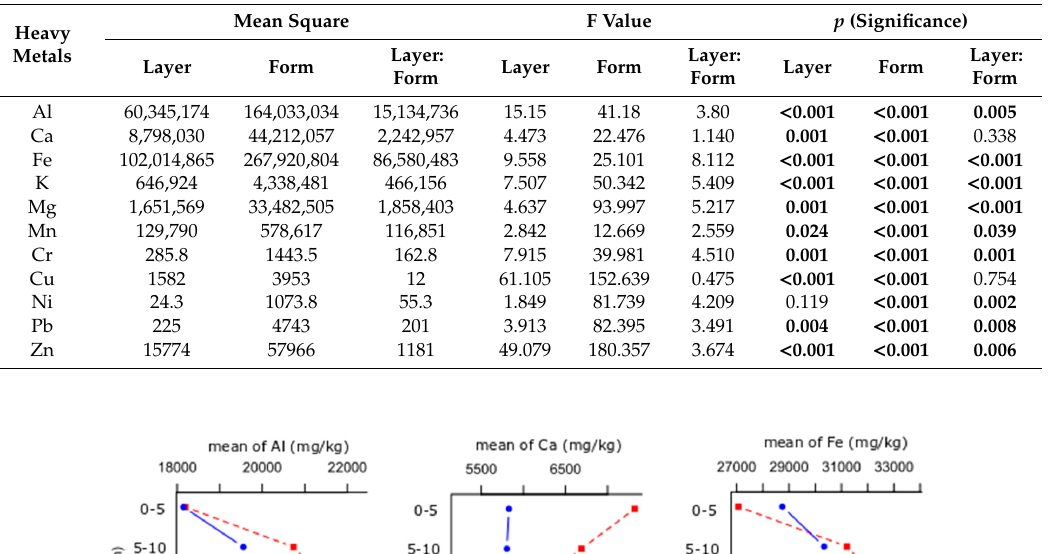
Table 3. Result of two-way factorial ANOVA by depth layers and landforms (highlighted with bold: p < 0.05).